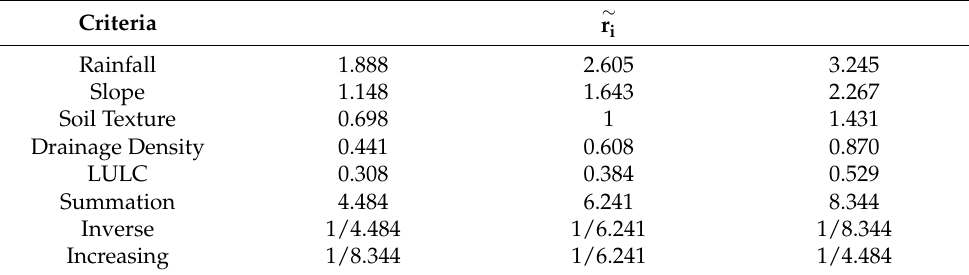
Table 9. The geometric mean of each